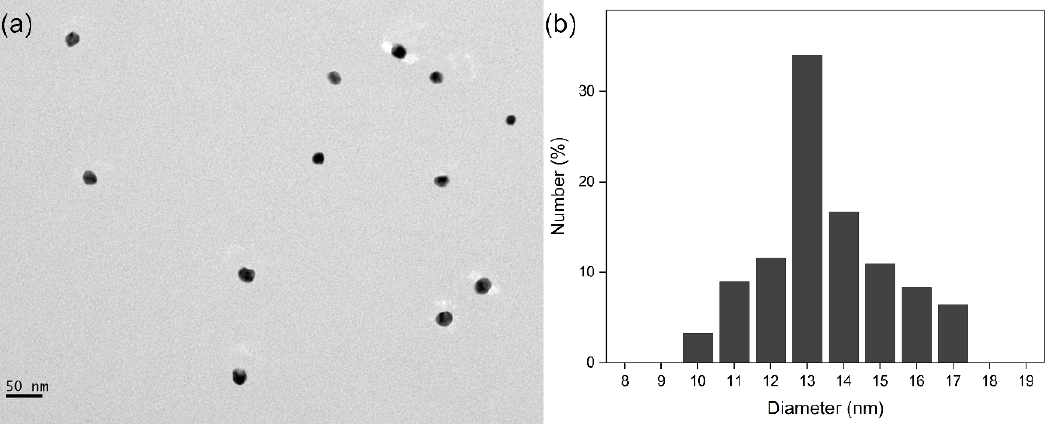
Figure 1. ( a ) Transmission electron microscopic image of AuNPs. ( b ) Size distribution of AuNPs.